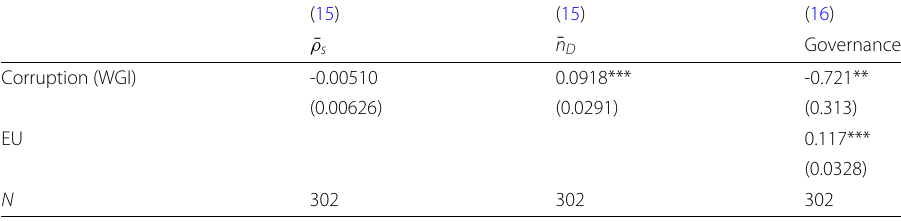
Table 3 Estimates using the aggregate WGI control of corruption